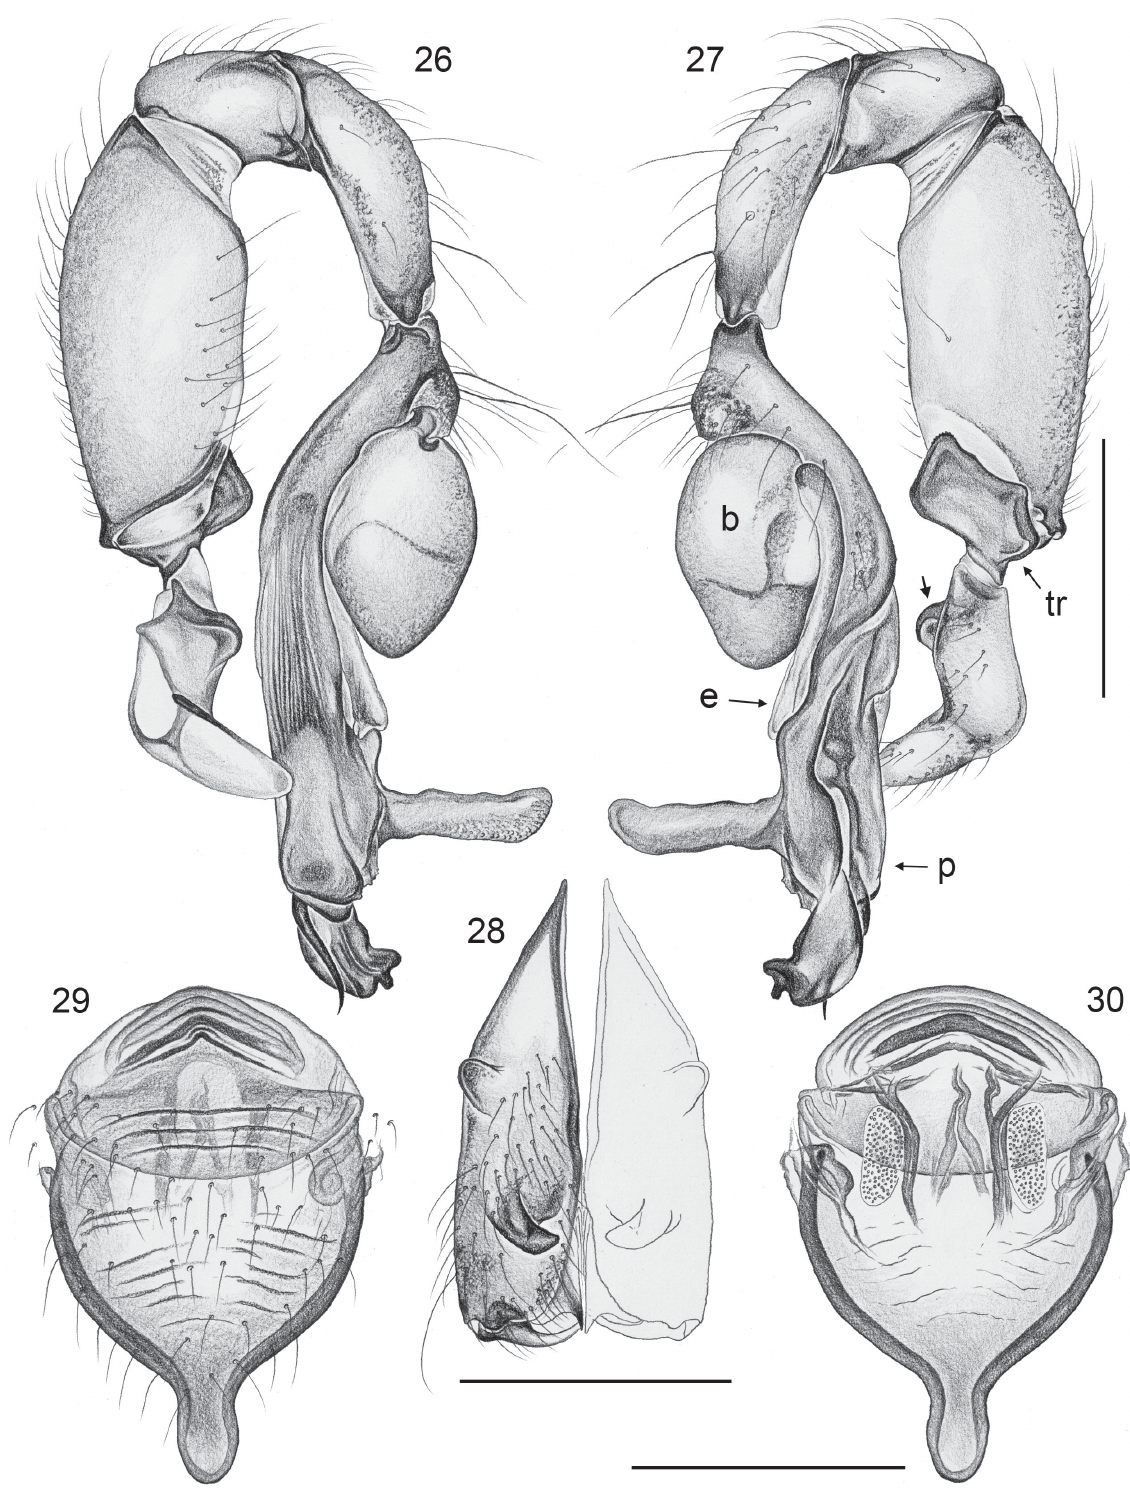
Figs 26–30. Hantu niah gen. et sp. nov., ZFMK Ar 15072–73. 26–27 . Left male palp, prolateral and retrolateral views (arrow points at ventral process on coxa). 28 . Male chelicerae, frontal view. 29– 30 . Cleared female genitalia, ventral and dorsal views. Abbreviations: b = genital bulb; e = embolus; p = procursus; tr = trochanter. Scale lines: 0.5 mm (26–27, 29–30); 0.3 mm